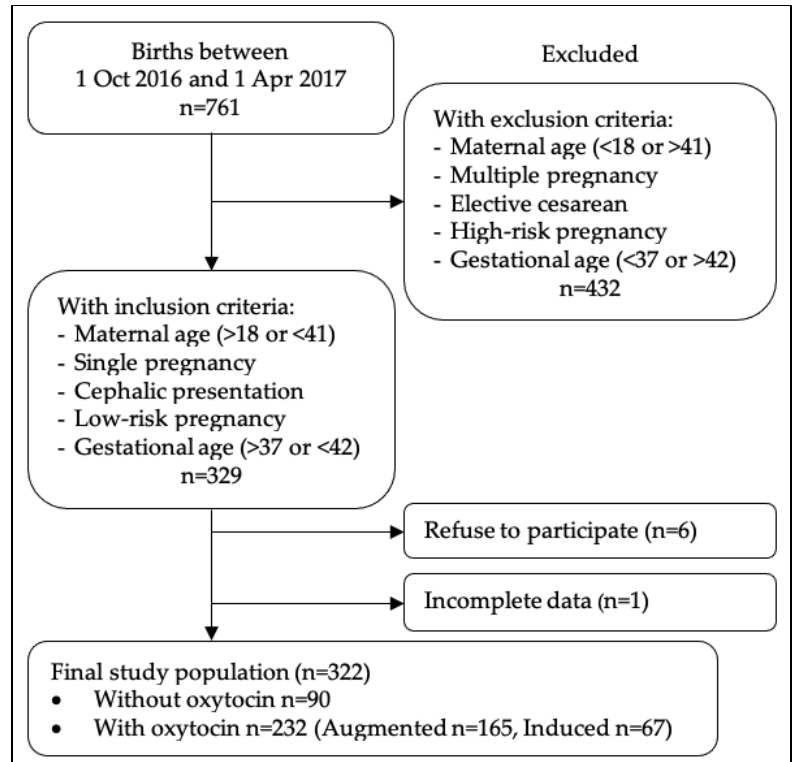
Figure 2. Flow chart of patient selection.